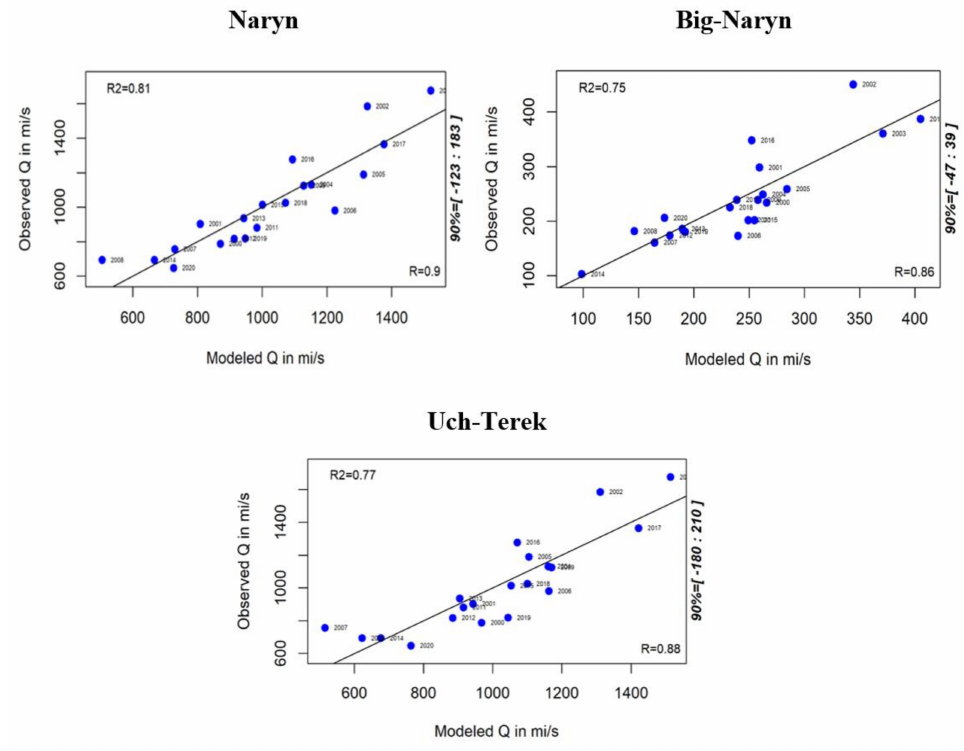
Figure 7. Linear forecast models for selected hydrological stations for the growing season. It can be used to determine the snow cover predictor for the monthly forecast. This graph shows the correlation between each month’s water discharge and the snow cover area in each elevation zone. As shown in Figure 8, different correlation values are obtained for different months and altitude zones. River discharge data from three stations with dissimilar physiographic and climatic regions were used, namely station Naryn, from the middle part of the Naryn river basin, station Big-Naryn from the upper basin area, and station Uch-Terek from the lower part of the basin area. Figure 8 showed three stations with different elevation zones, it explained that stations have different altitudes due to geographical conditions that one of the stations has eight elevation zone and the others six zones with 500 m intervals. This is the correlation matrix between snow cover at different elevation zones and monthly discharge. The equations representing these correlations do not give any added value in representing the relationship between these two variables. Therefore, we do add equations as they are already represented by the R values in the matrix figure. The positive tendencies are mostly present in May and June in the lower part of the basin at station Uch-Terek is 0.60–0.87 at the 2000–3000 m elevation zone. In the middle part of the basin at Naryn station, the correlation shows 0.76 at the 2500–3000 m elevation zone. From May to July, the station Big-Naryn showed the best correlation of 0.70–0.84 at elevation 3000–3500 m in